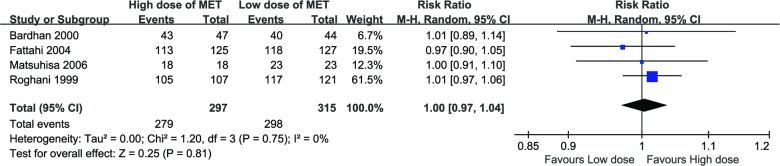
Forest plot of adherence difference between high-dose therapies and low-dose therapies.